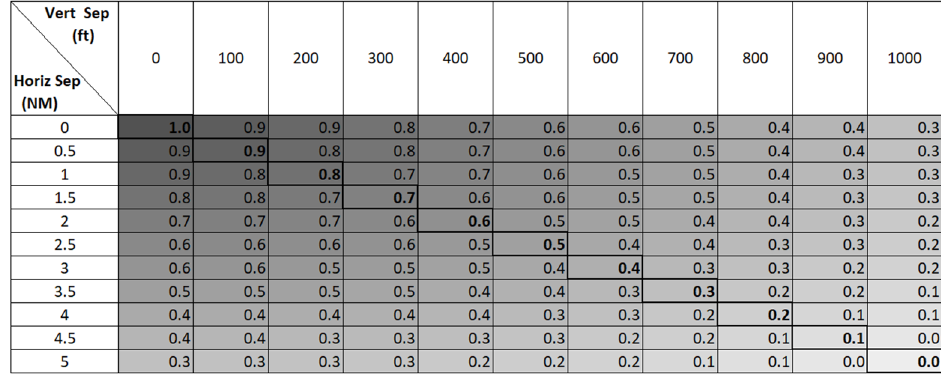
Figure 5. Risk array for LOS criticality.